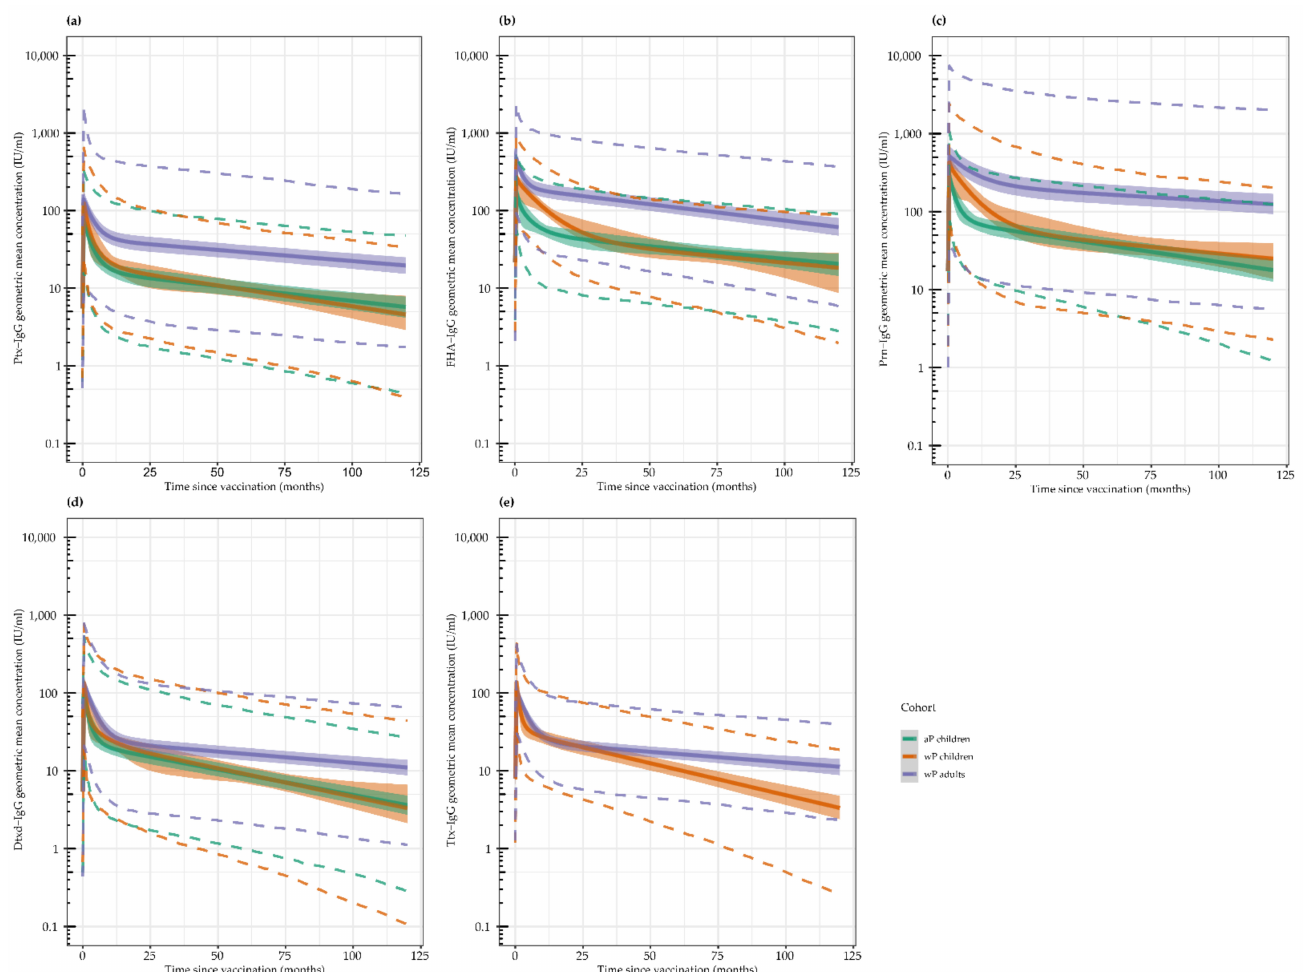
Figure 2. Modelled IgG antibody concentrations from time of vaccination (0 months) up to 10 years (120 months) post-vaccination in acellular pertussis (aP) primed children, whole cell pertussis (wP) primed children, and wP-primed young adults, as the colours in the legend indicate. Modelled geo- metric mean IgG concentrations are shown (solid lines) with their respective 95% confidence interval (ribbons). Dashed lines show the range where 95% of most probable predictions lie. Datapoints underlying this model can be viewed in Supplementary Figure S2. Acellular primed children are missing in the tetanus toxin model because of interference from another (non-pertussis) vaccine in between the last two timepoints. IU: international units; Ptx: pertussis toxin; FHA: filamentous haemagglutinin; Prn: pertactin; Dtxd; diphtheria toxoid; Txt: tetanus toxin; IgG: immunoglobulin G. Modelled IgG antibody concentrations for ( a ): pertussis toxin, ( b ): filamentous